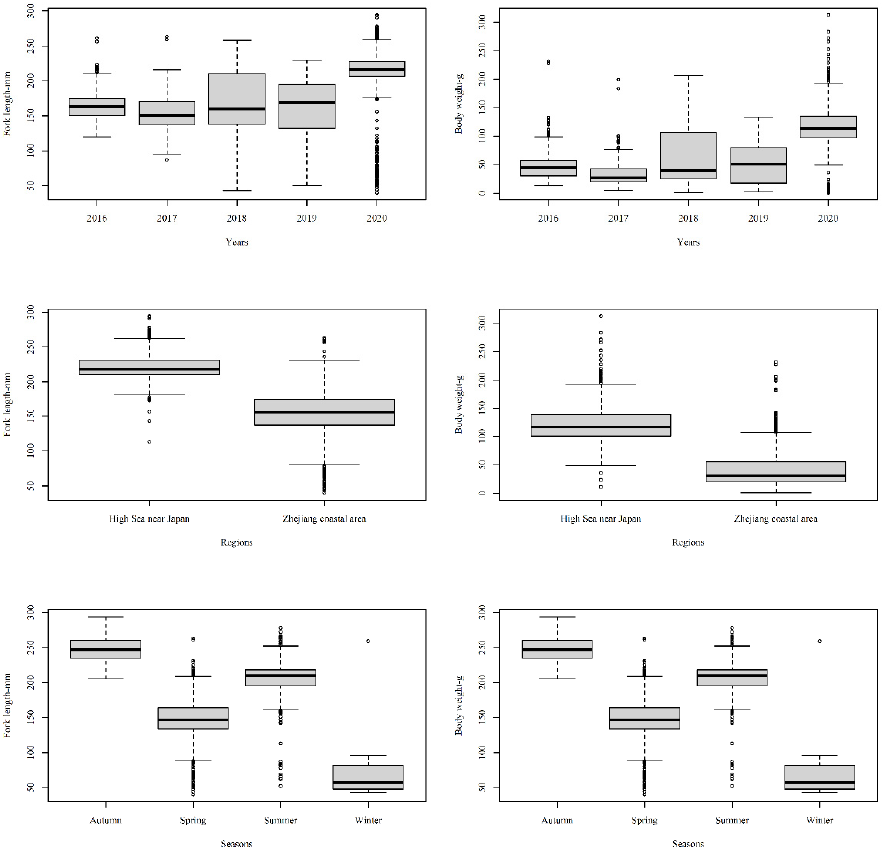
Figure 3. Changes in fork length and body weight distribution of Chub mackerel specimens collected from waters off the northwest Pacific Ocean presented by years, seasons (spring, summer, and autumn), and regions.